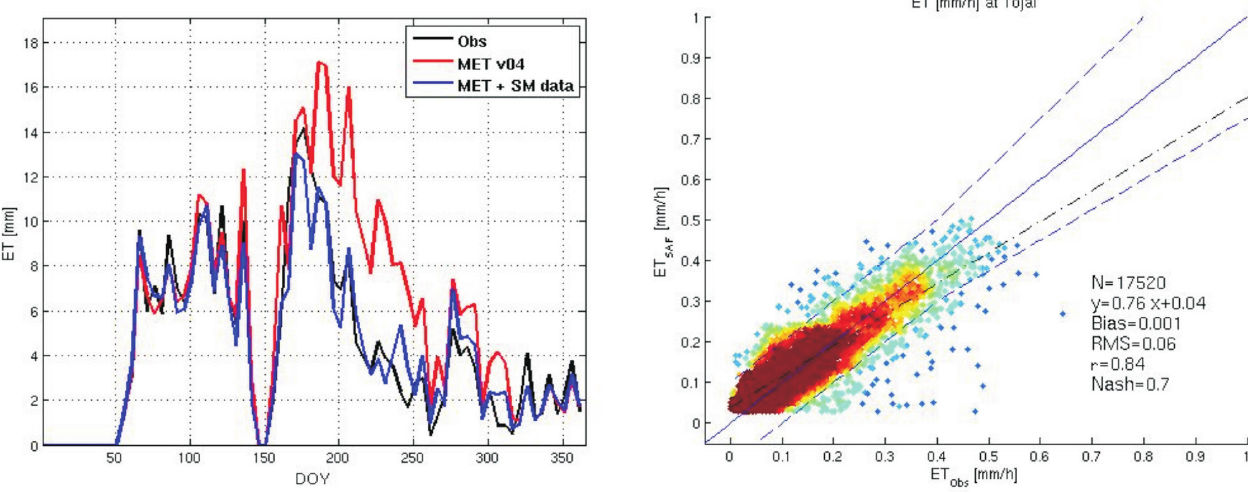
Fig. 9. Left: time series of the 5-days cumulated ET measured (black) and modelled (red) for the CarboEurope-IP Tojal station (Portugal) for the period from March to November 2007 as provided by LSA SAF MET. Modelled ET using soil moisture measured at the station (blue) has been superimposed. Right (as in Fig. 3) but modelled ET computed with soil moisture measured at the station compared to 30min mean observed